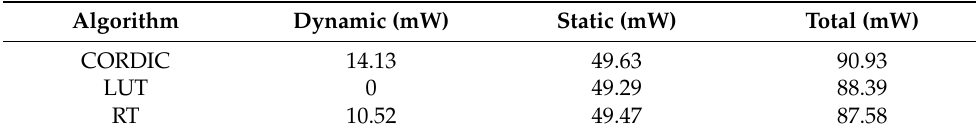
Table 7. Comparison of the power consumption using the related algorithms.